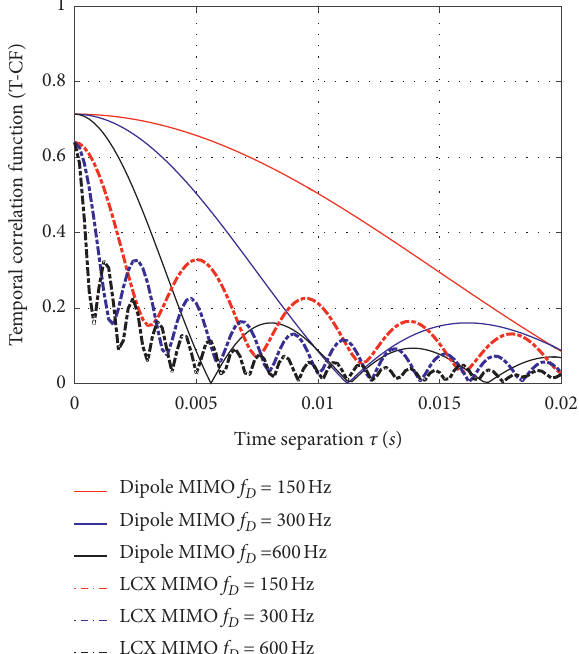
Figure 7: T-CF of dipole MIMO and T-CF of LCX-MIMO with different Doppler shifts f (360 km/h)] of the receiver and d � 4.8 λ , K 11 � K 12 � 4dB, l �